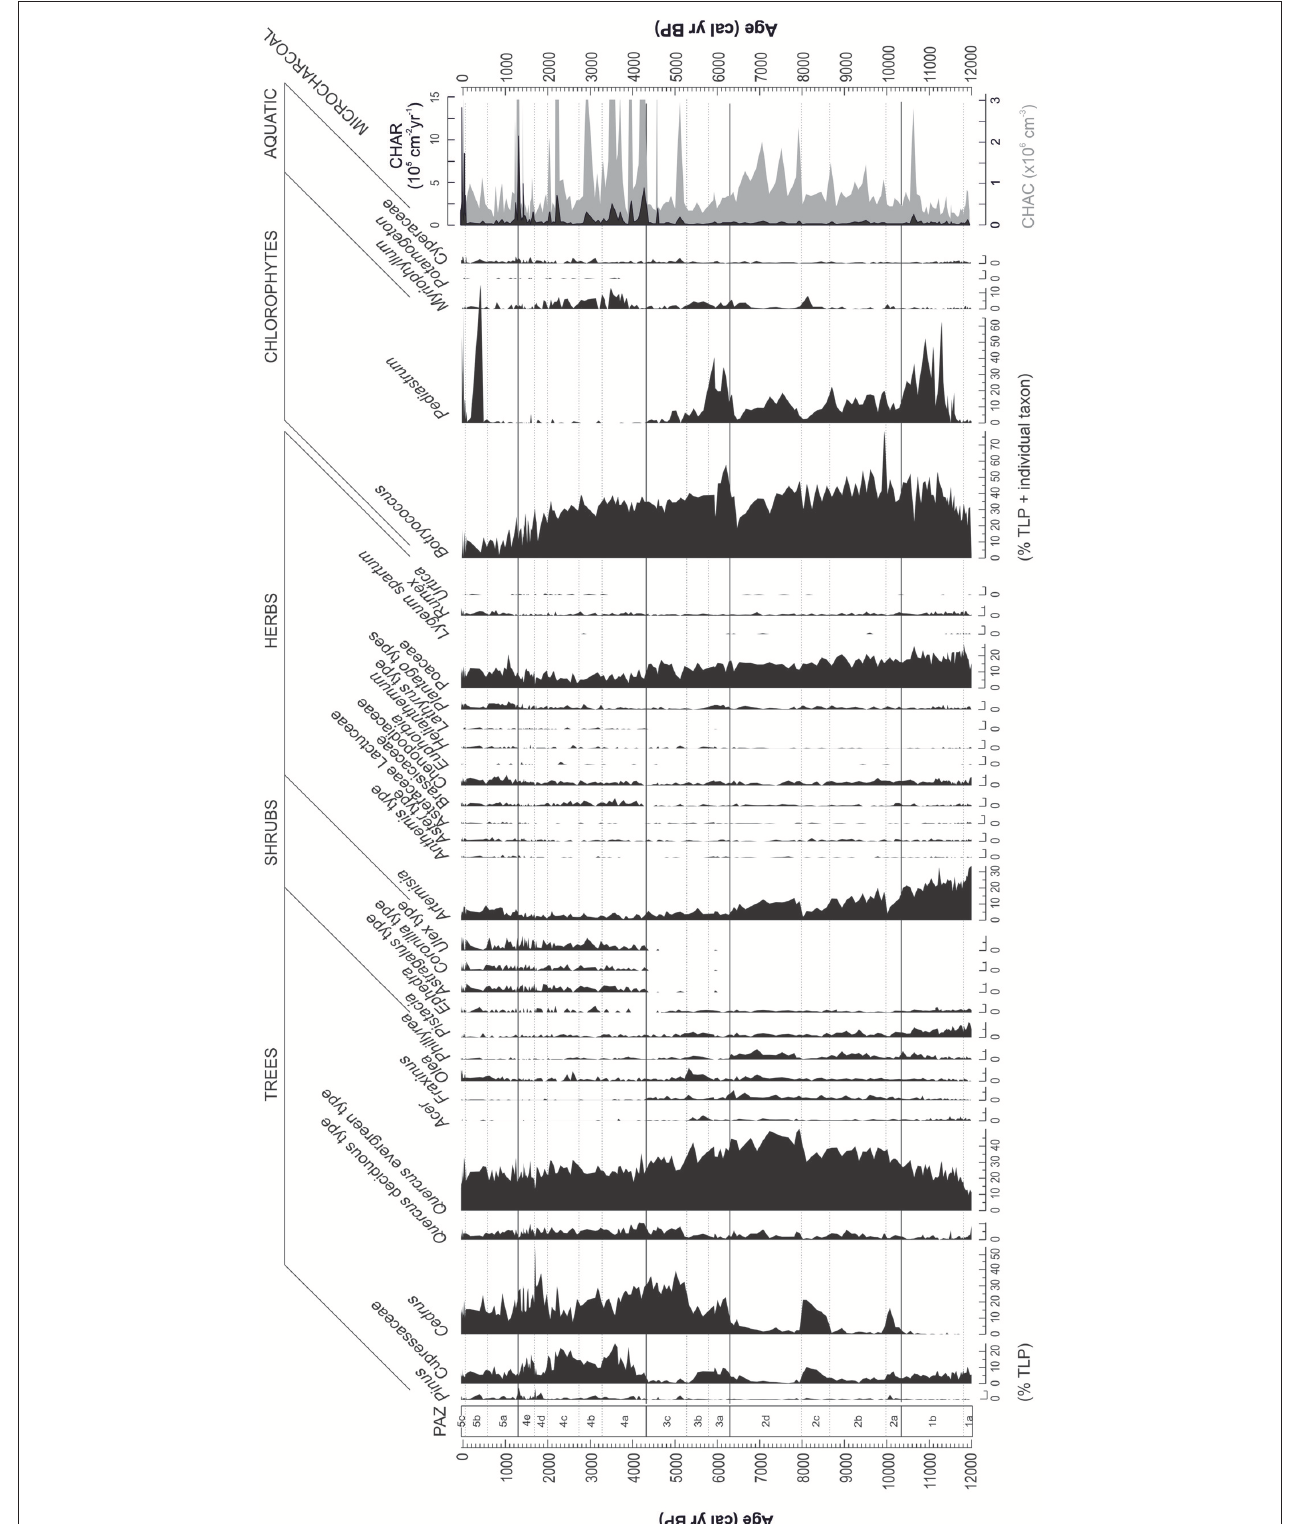
FIGURE 6 | Select pollen, NPPs and microcharcoal data from Lake Sidi Ali (cores ALI 01-10) plotted against age. Pollen percentages calculated against a main sum of total land pollen (TLP) which excludes aquatics and spores.